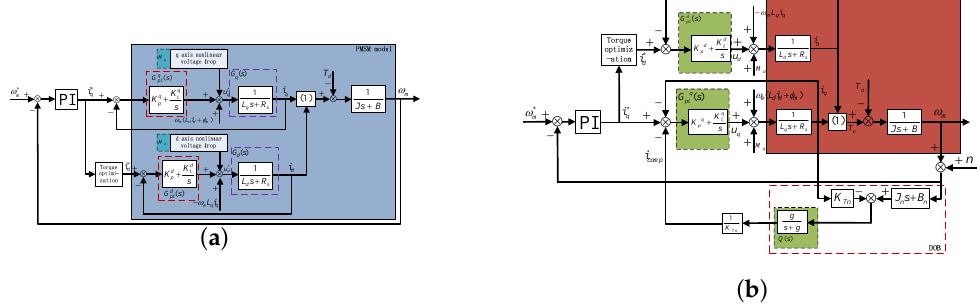
Figure 3. Equivalent control block diagram of inverter compressor: ( a ) FOC; ( b ) FOC with general